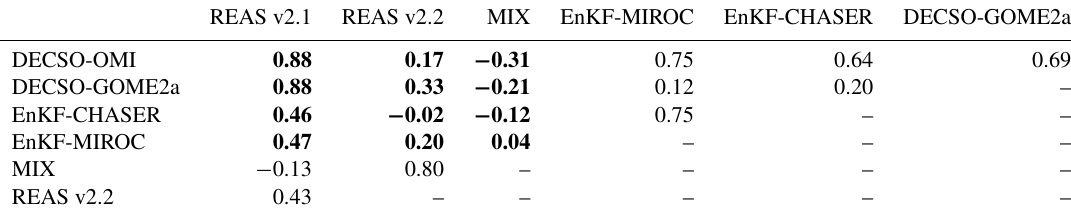
Table 4. Same as Table 3, but for rural areas in